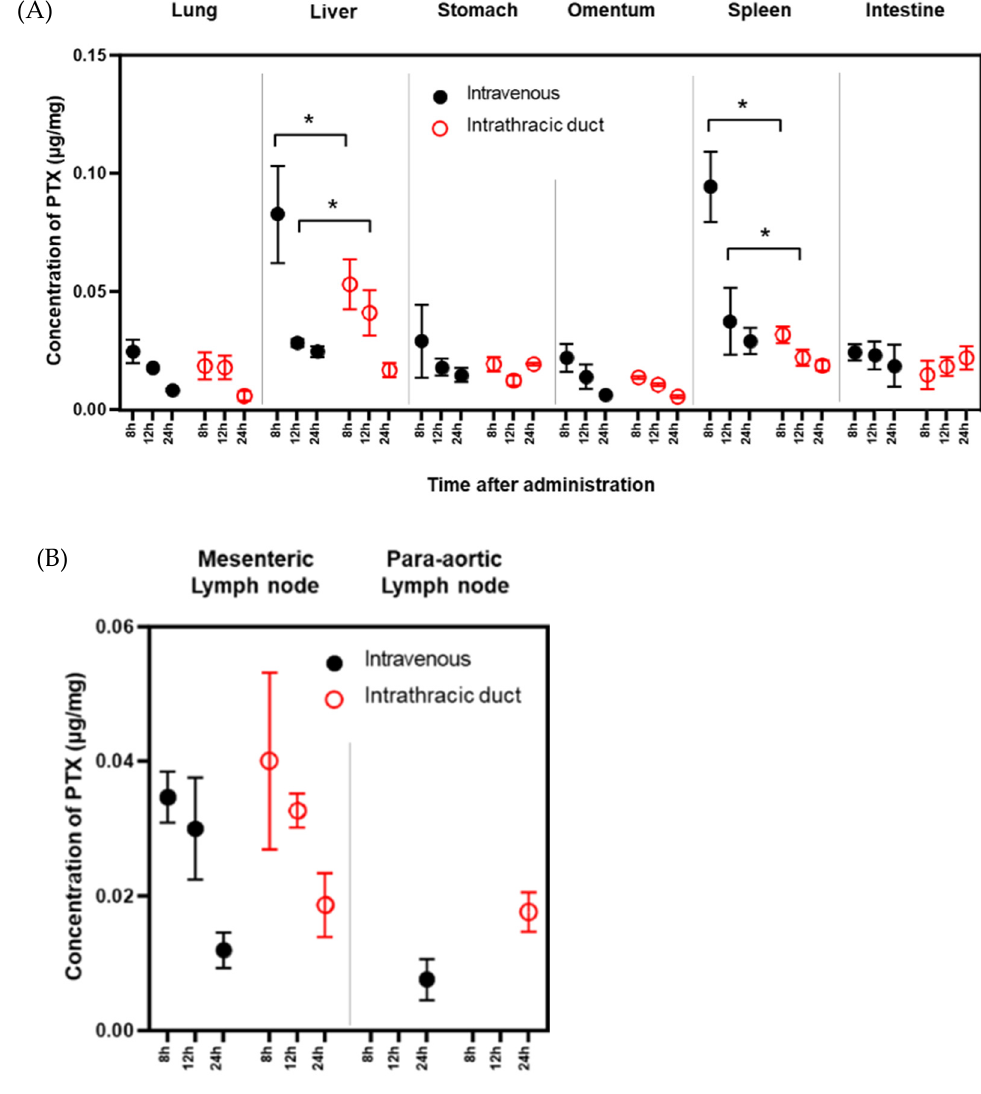
Figure 5. PTX concentrations in various organs ( A ) and various lymph nodes ( B ) at later time points after IT or IV injection. Three samples were obtained from each organ 8, 12, and 24 h after infusion. PTX concentrations were measured with a mass spectrometer (LC-MS/MS). Data show the mean ± SD of three samples. *: p < 0.01.